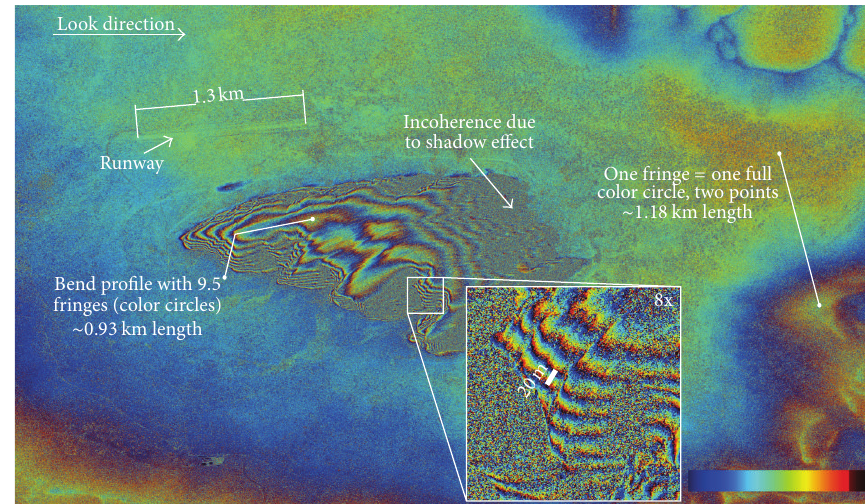
Figure 10: Interferogram generated with DORIS using the cc6p SP interpolation kernel. Temporal baseline is 11 days and perpendicular baseline is 233.7 m with a height ambiguity of 34m. Master acquired on 2009-02-12 and slave on 2009-02-23.